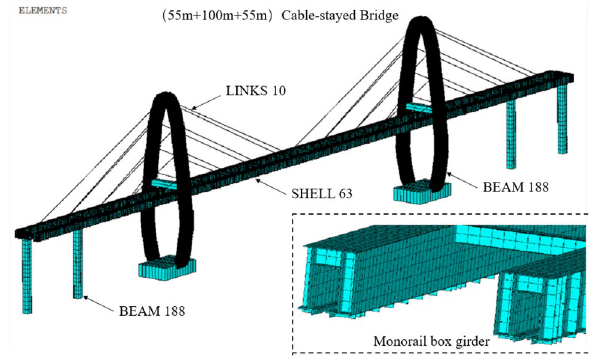
Fig. 3 Monorail vehicle dynamics model Table 1 Degrees of freedom of STM monorail vehicle Vehicle part